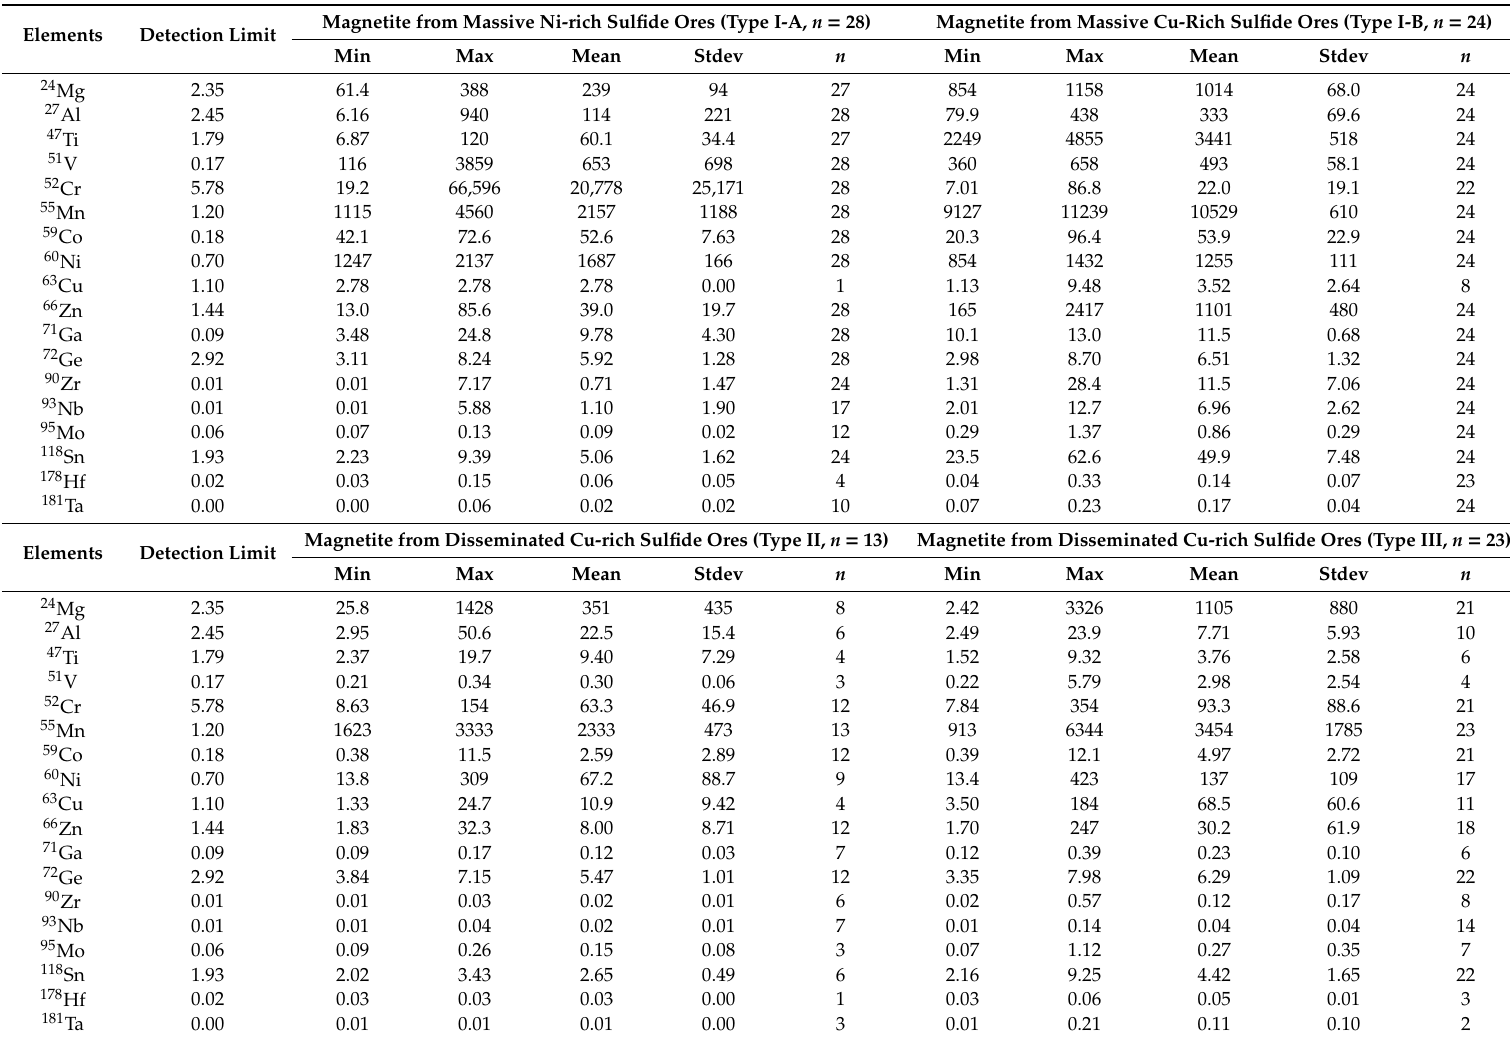
Table 2. Summary of LA-ICP-MS results for representative trace elements (in ppm) of di ff erent magnetite types in the Jinchuan Ni-Cu-PGE